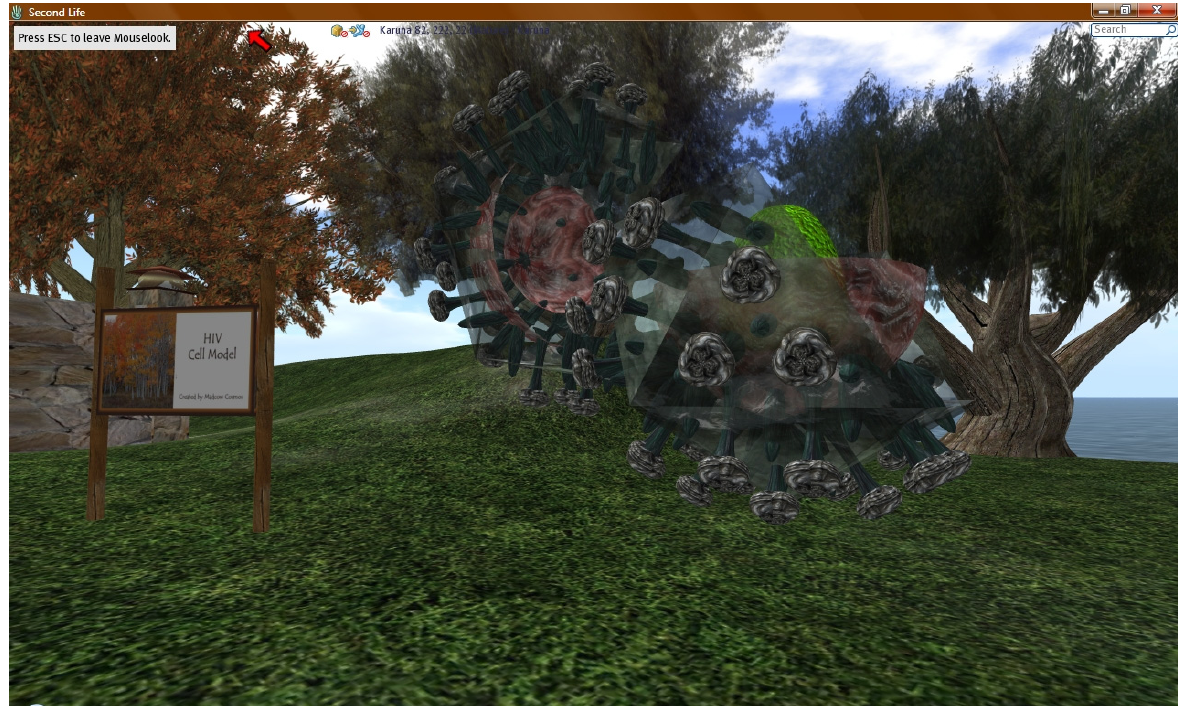
Figure 5. A 3D HIV Cell Model at Karuna